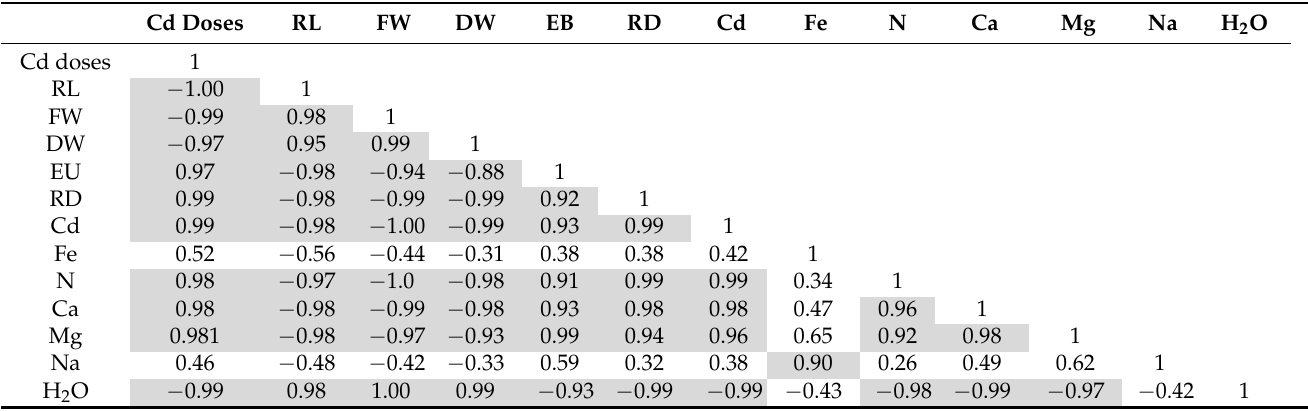
Table 2. Correlation matrix between cadmium doses applied, growth parameters, Evans blue uptake, mineral and water content in roots after applying cadmium nitrate to the growth medium.